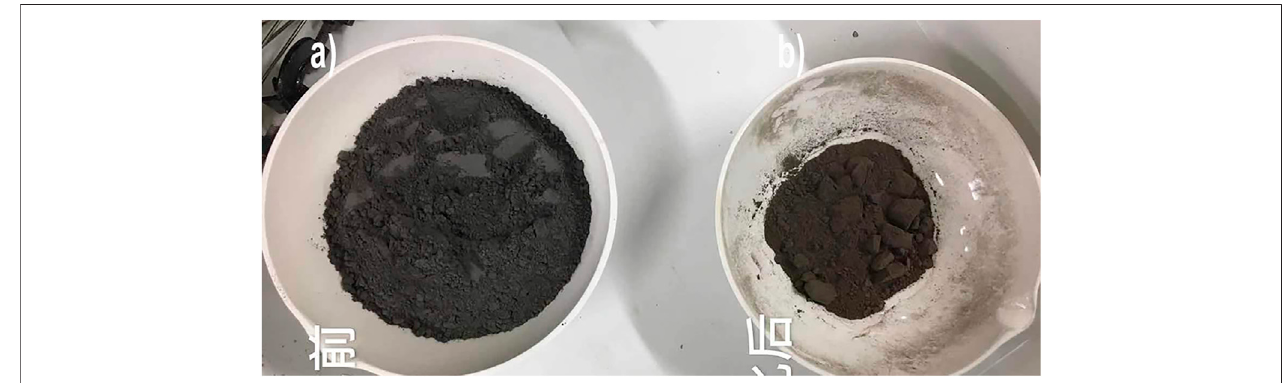
FIGURE 1 | Photos of original EAF steel slag (A) and carbonated EAF slag (B) .